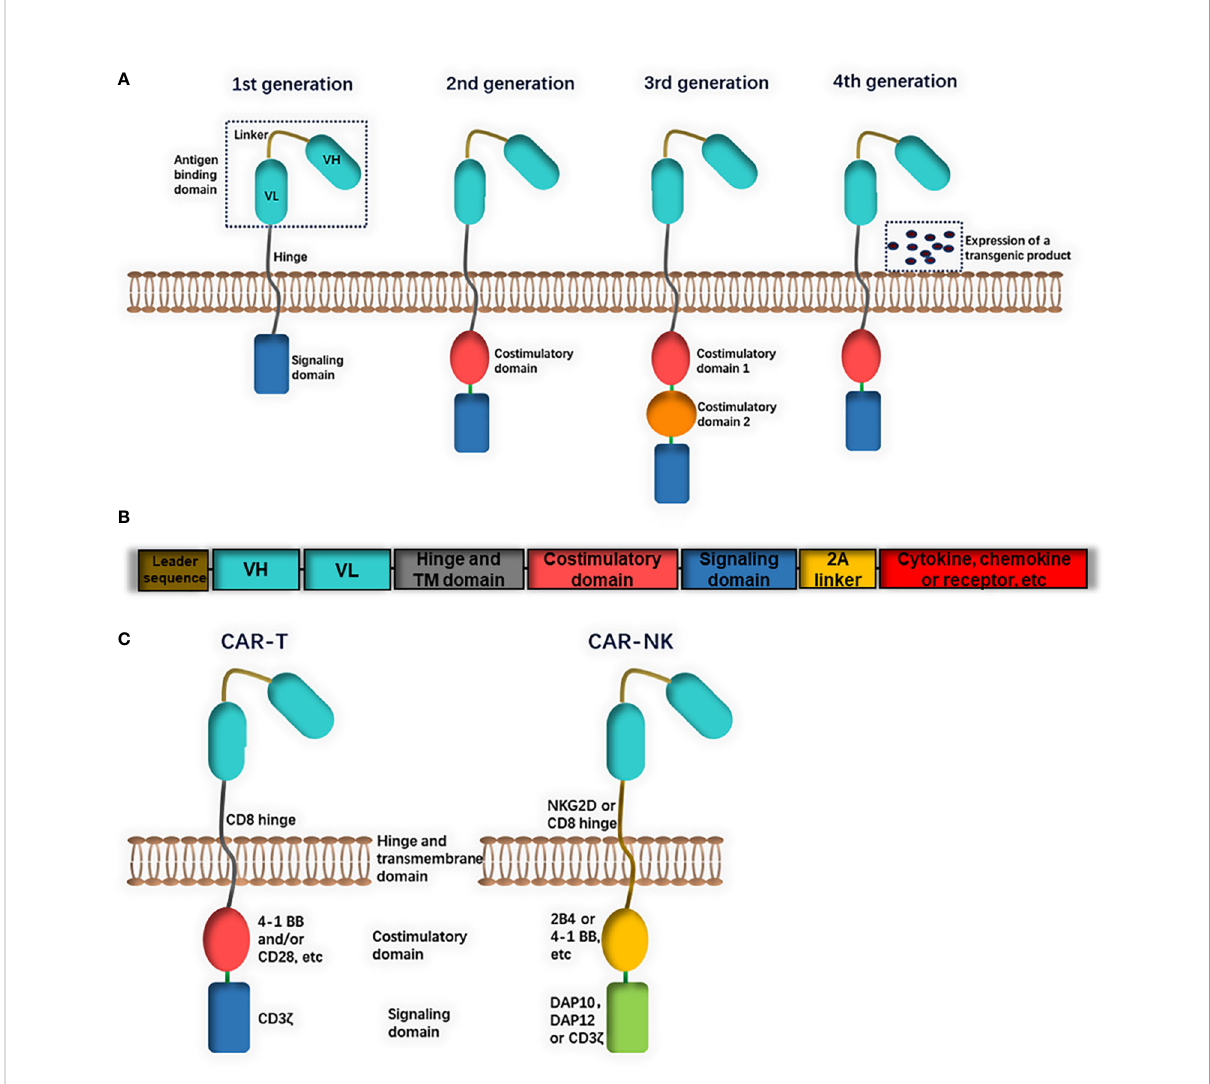
FIGURE 1 The structure of chimeric antigen receptors (CAR). (A) CAR consist of an extracellular antigen binding domain, a transmembrane hinge and intracellular domain. The extracellular domain could be a single chain fragment of variable region (ScFv) antibody or a functional domain of speci fi c ligand. The intracellular domain is composed of a signaling domain ( fi rst generation) and one costimulatory domain (second generation) or two (third generation). (B) Fourth generation CARs include a constitutive or inducible expression of a transgenic product (cytokine, chemokine or receptor, etc.). (C) Differences in CAR constructs between CAR-T and CAR-NK: CAR-T cells usually contains a CD8 transmembrane domain, CD3 z signaling domain and 4-1BB and/or CD28 costimulatory domain. CAR-NK cells may be with different domains (for example, NKG2D transmembrane domain, DAP10 or DAP12 signaling domain and 2B4 costimulatory